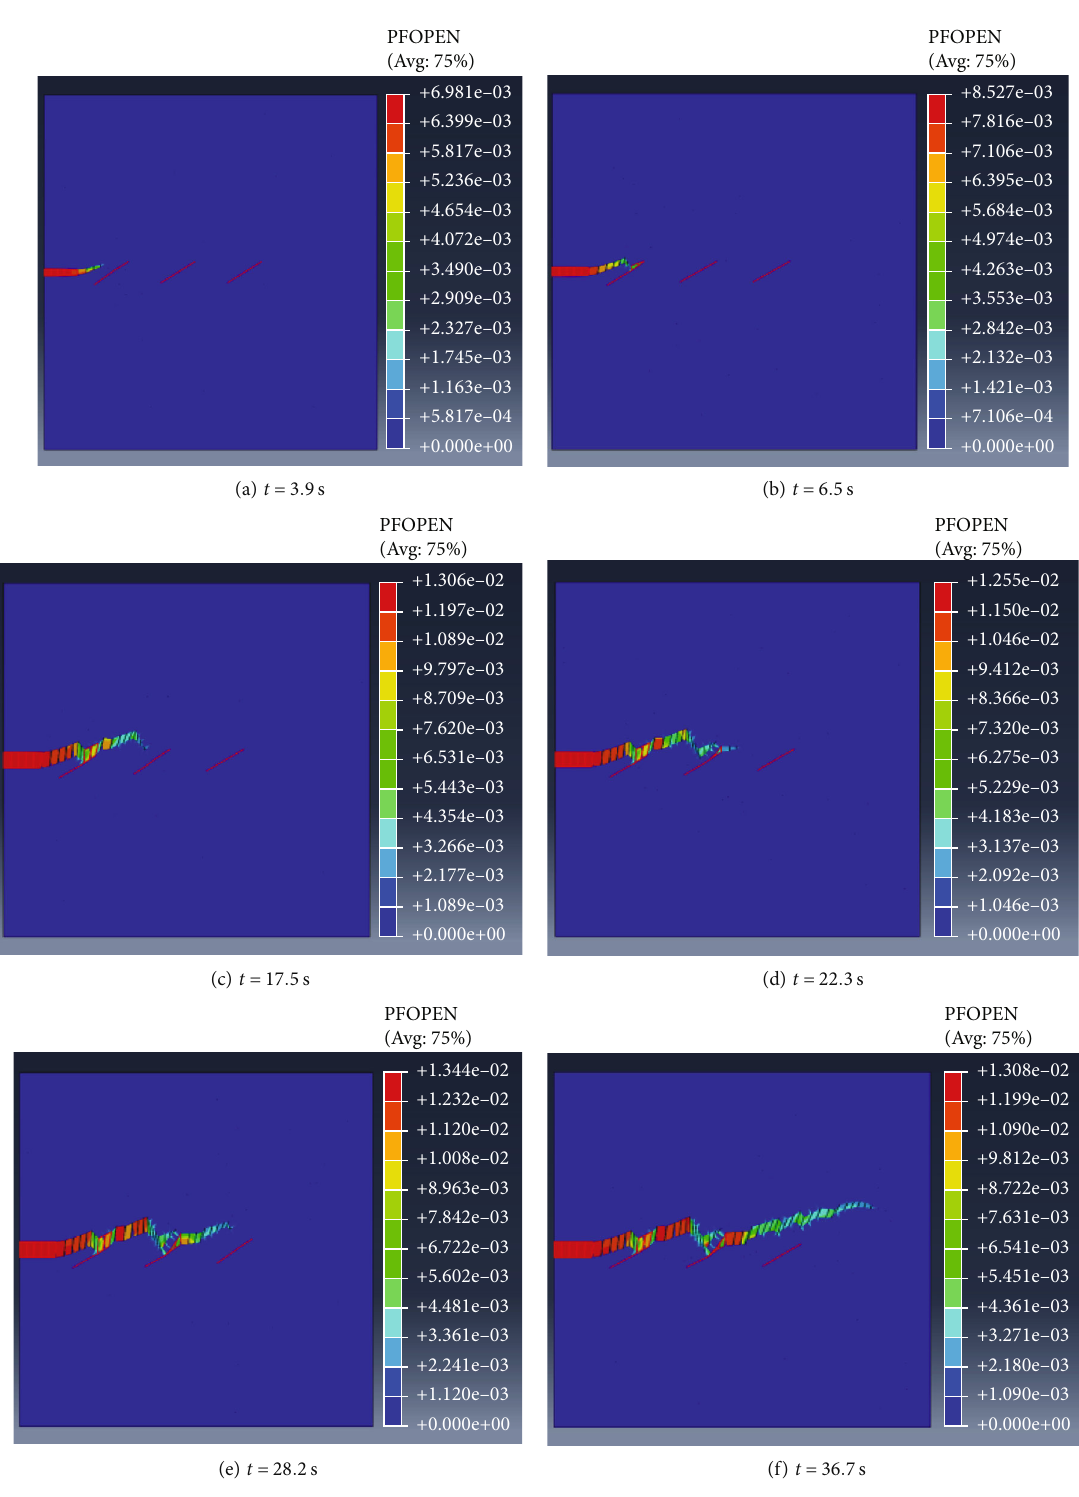
Figure 21: HF propagation at the NF approaching angle of 45 ° and stress anisotropy coe ffi cient of